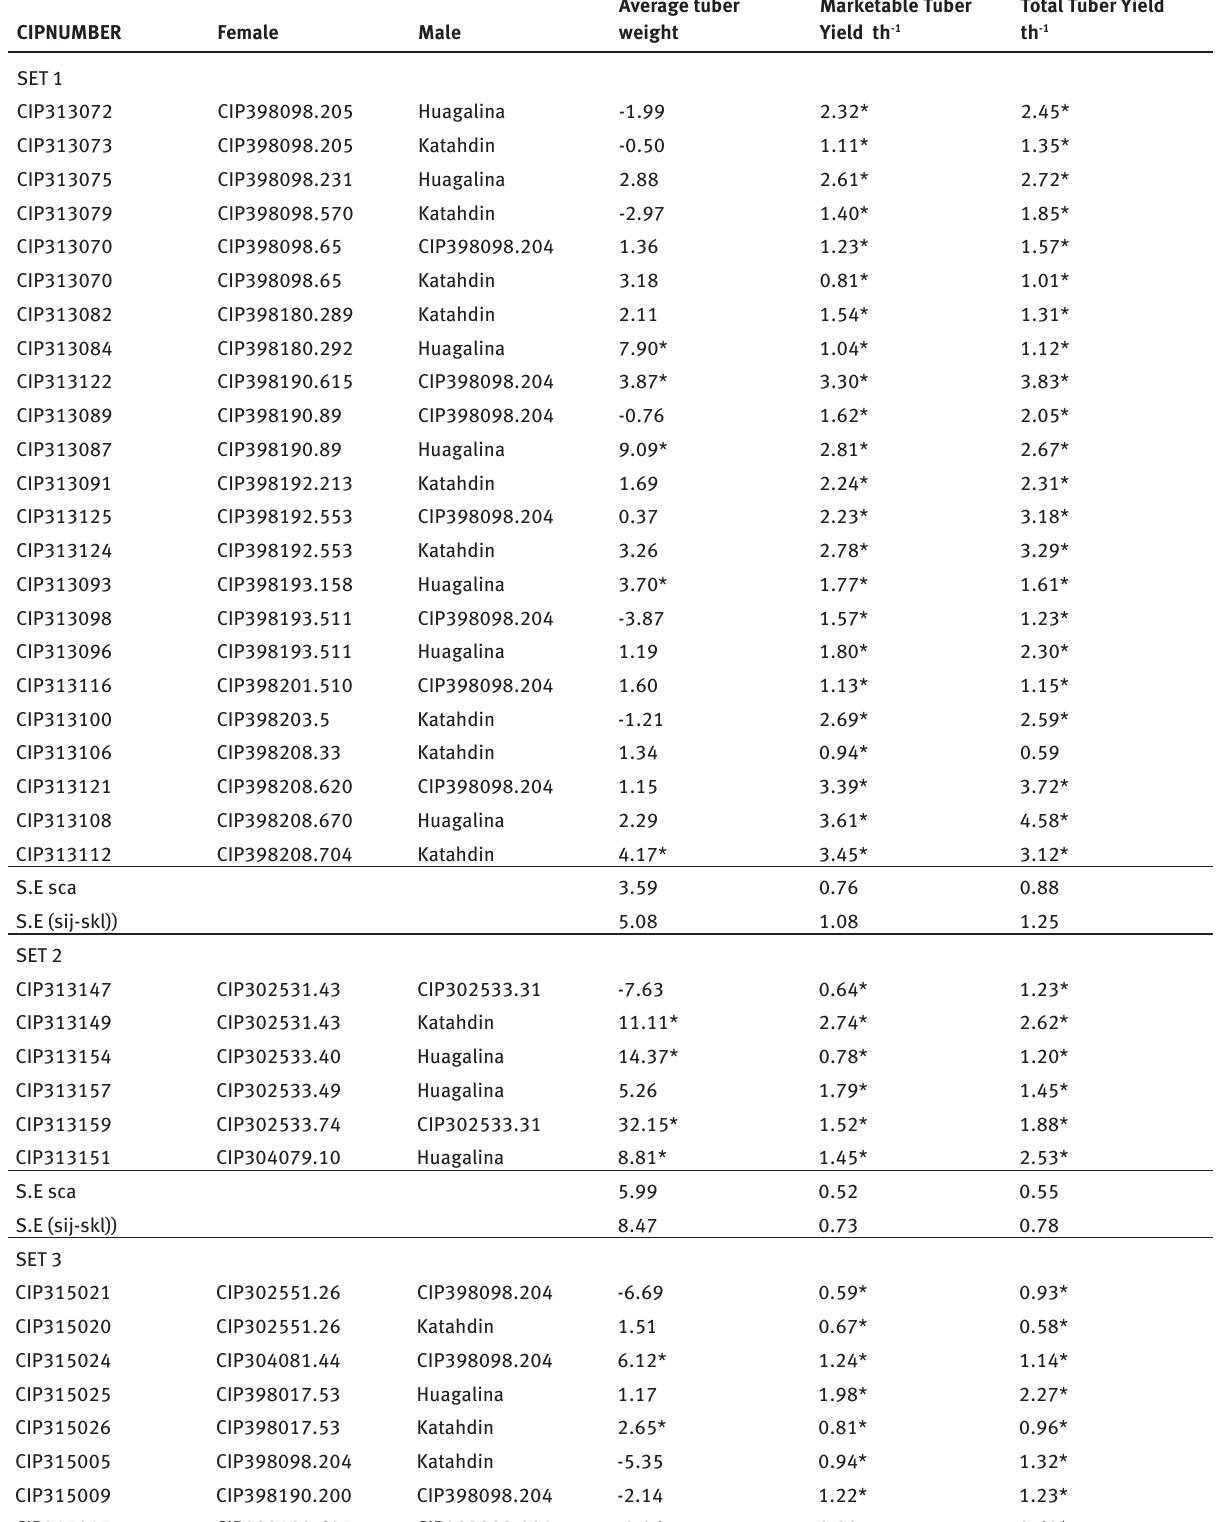
Table 8: Estimates of Specific Combining Ability (SCA) effects in progenies, statistically significant pooled over locations for average tuber weight, marketable and total tuber